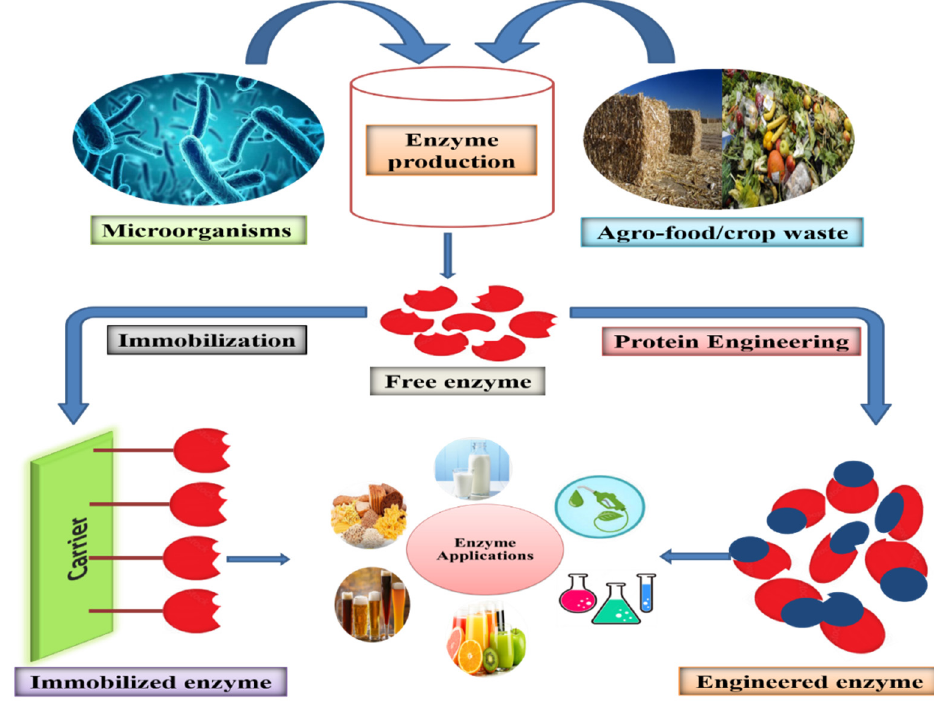
Figure 1. Schematic representation of developing efficient biocatalysts.